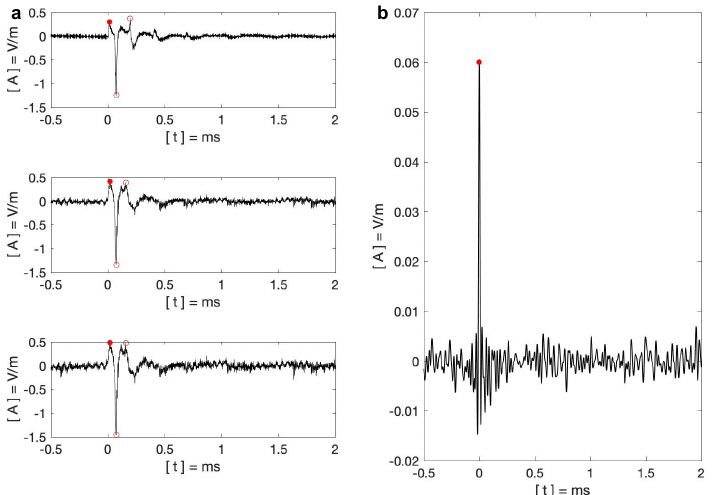
Figure 8. ( a ) Amplitude waveforms used in the simulation with 105 receiver network. The middle figure is the scaled amplitude waveform; the bottom figure is the ratioed amplitude waveform; and the upper figure is the amplitude waveform of 1150 km from the amplitude waveform bank. The ground wave maxima are marked with red dots, and the skywave maxima are marked with red open circles. ( b ) The amplitude waveform calculated by the filtered waveforms. The maximum is marked with a red